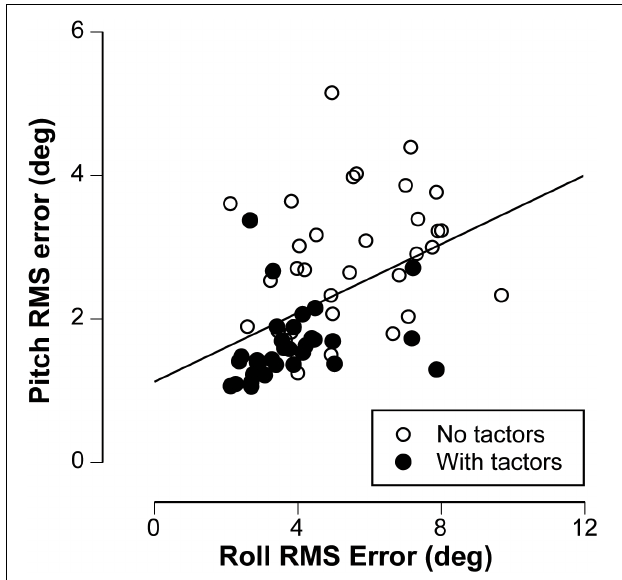
FIGURE 5 | Plot of the relationship between the nulling performance in pitch vs. the nulling performance in roll, including trials without (open symbols) and with (filled symbols) vibrotactile feedback. The line represents best linear fit, characterized by Spearman’s correlation (rho = 0.496, p <